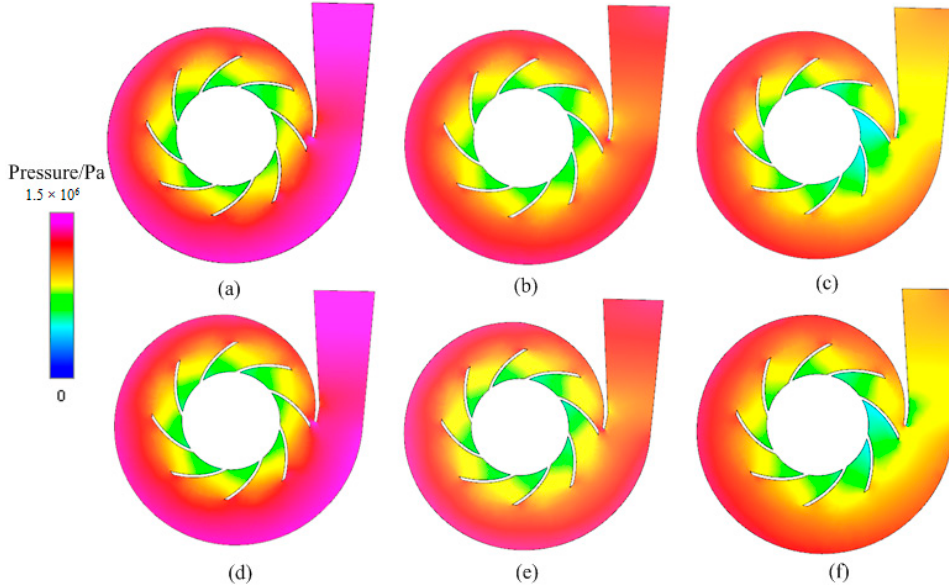
Figure 8. Static pressure and relative velocity distributions at the axial section: ( a ) combination impeller, 0.8 Q d ; ( b ) combination impeller, 1.0 Q d ; ( c ) combination impeller, 1.2 Q d ; ( d ) conventional impeller, 0.8 Q d ; ( e ) conventional impeller, 1.0 Q d ; ( f ) conventional impeller, 1.2 Q d